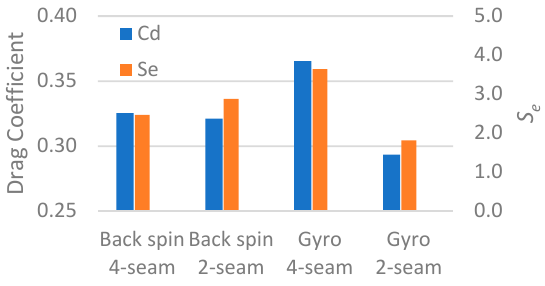
Figure 8. The comparison between S e and the average drag coefficient of each spin